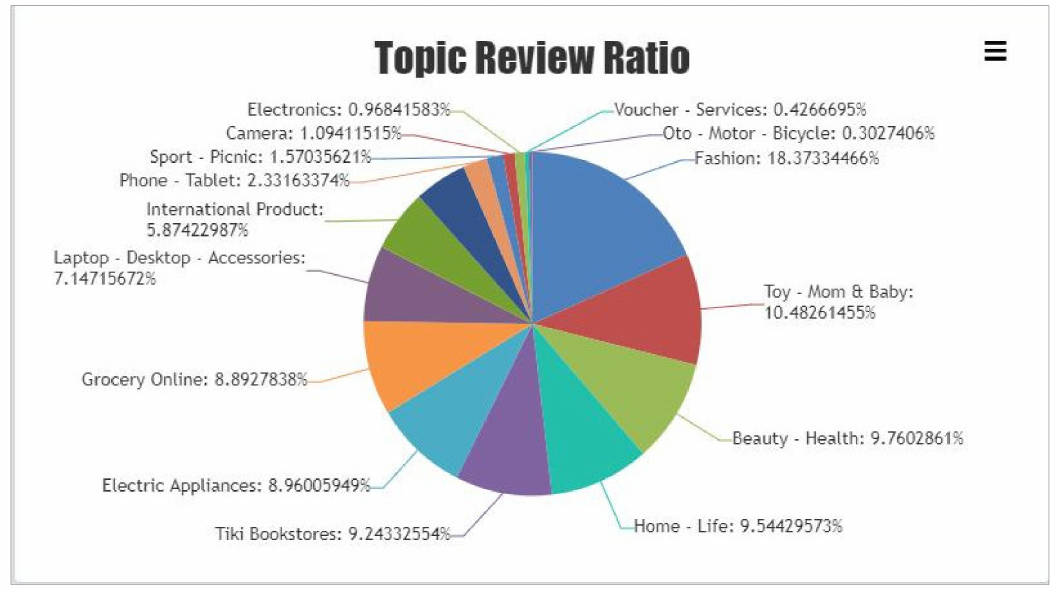
Figure 12. Summarizations of topic review ratio